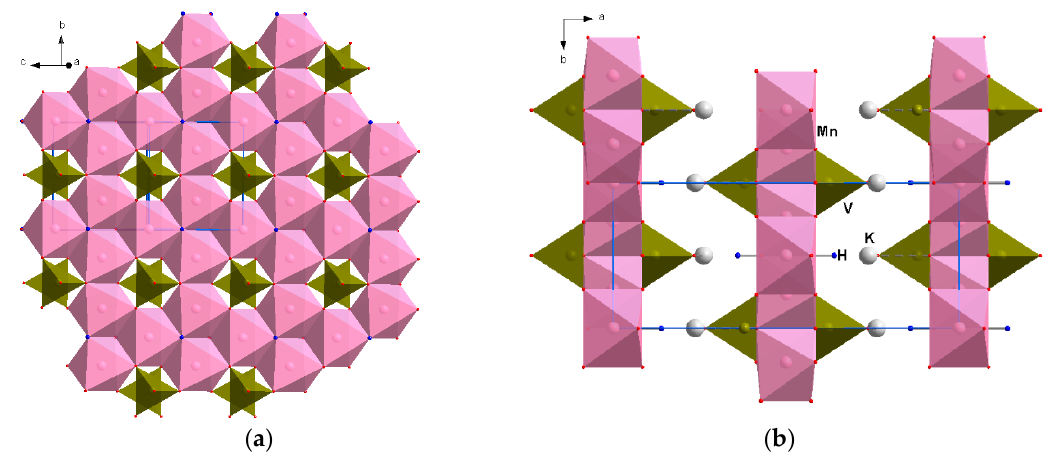
Figure 8. The crystal structure of K 2 Mn 3 (OH) 2 (VO 4 ) 2 in [101] ( a ) and [001] ( b ) projections.